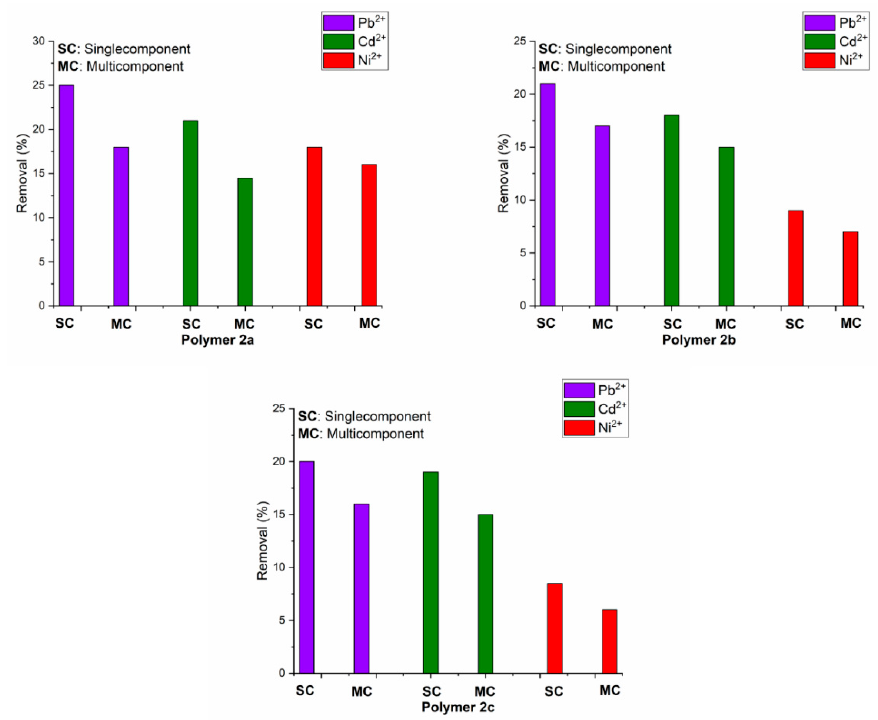
Figure 10. Percent removal of individual metals and in a ternary mixture of metals by the thi ‐ ol ‐ functionalized polymers. functionalized